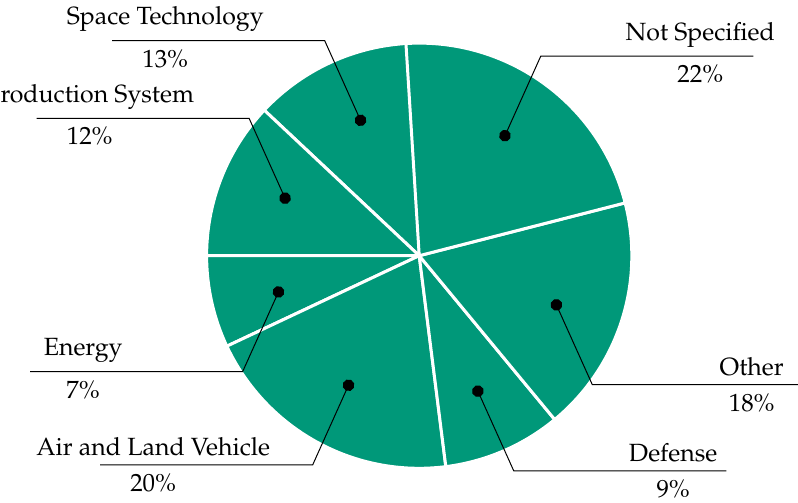
Figure 6. Distribution of publications in context of the investigated target system’s